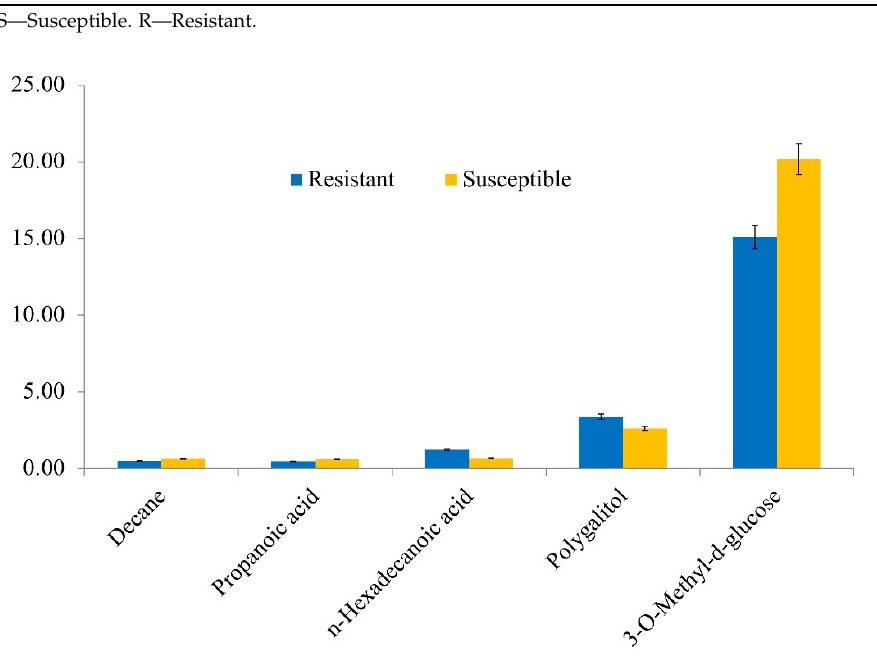
Figure 4. Fold change analysis of the common metabolites.